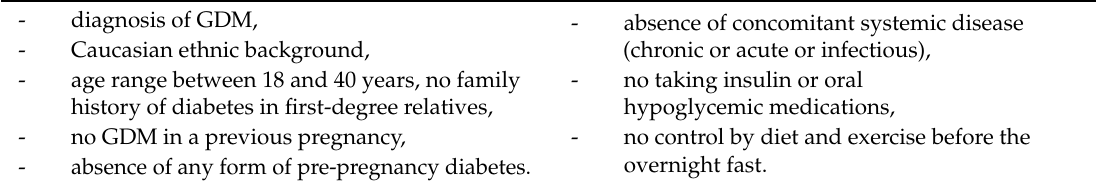
Table 7. Inclusion criteria used for the patients’ participation in the